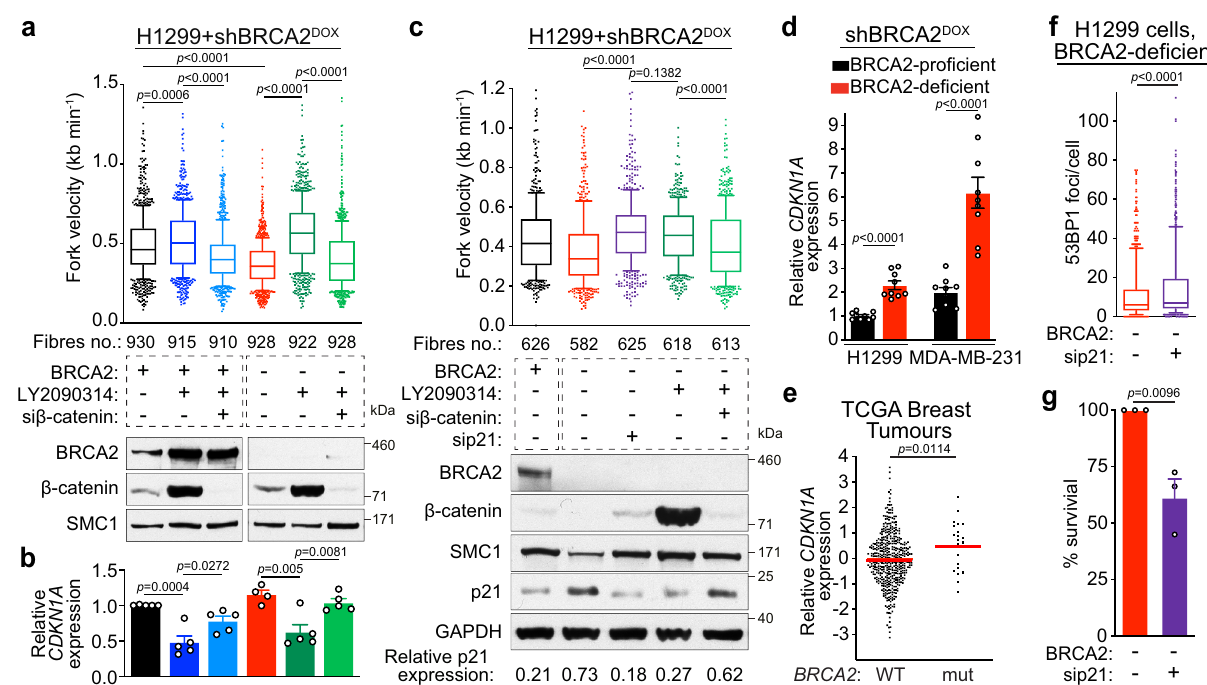
Fig. 7 Oncogenic β -catenin accelerates replication fork progression by downregulating p21 expression. a H1299 cells expressing a DOX-inducible BRCA2 shRNA were transfected with control or β -catenin siRNAs and grown in the presence ( − BRCA2) or absence ( + BRCA2) of DOX, or LY2090314. Cells were pulse labelled with CldU followed by IdU for 20 min each. CldU + IdU track length was used to determine fork velocity. Whole-cell extracts prepared at the time of analysis were immunoblotted with SMC1 as a loading control. Fibres quanti fi ed from n = 3 independent experiments. b qRT-PCR analyses of H1299 cells grown as in ( a ), for CDKN1A . mRNA levels expressed relative to the gene encoding GAPDH and untreated BRCA2-pro fi cient cells (2 − ΔΔ CT ). Error bars represent SEM of n = 5 independent experiments. Statistical signi fi cance was determined by an unpaired two-tailed t -test. c DNA fi bre analysis as in ( a ) of cells also transfected with p21 siRNA. Whole-cell extracts were immunoblotted with SMC1 and GAPDH as loading controls. p21 expression was quanti fi ed relative to GAPDH control. Fibres quanti fi ed from n = 2 independent experiments. d qRT-PCR analyses as described in ( b ) for H1299 and MDA-MB-231 human cells carrying a DOX-inducible BRCA2 shRNA grown in the presence (BRCA2-de fi cient) or absence (BRCA2-pro fi cient) of DOX for 28 days. Error bars represent SEM of n = 3 independent experiments. Statistical signi fi cance was determined by an unpaired two-tailed t -test. e CDKN1A mRNA expression in TCGA breast tumours ( n = 459 for WT; n = 22 for BRCA2 -mutated; 77 ). Each dot represents a single tumour. Middle line, mean. Statistical signi fi cance was determined by a two-tailed Mann – Whitney test. f Quanti fi cation of 53BP1 foci in BRCA2-de fi cient H1299 cells, 7 days after transfection with control or p21 siRNAs ( n = 3 independent experiments; ≥ 200 cells per experiment). g Clonogenic survival assays in BRCA2- de fi cient H1299 cells transfected with control or p21 siRNAs. Error bars represent SEM of n = 3 independent experiments. Statistical signi fi cance was determined by an unpaired two-tailed t -test. For a , c and f boxes indicate the median value and 25th – 75th percentile, whiskers indicate the 10th and 90th percentiles, and statistical signi fi cance was determined by a two-tailed Mann – Whitney test. Source data for ( a – d ) and ( f , g ) is provided in the Source data fi